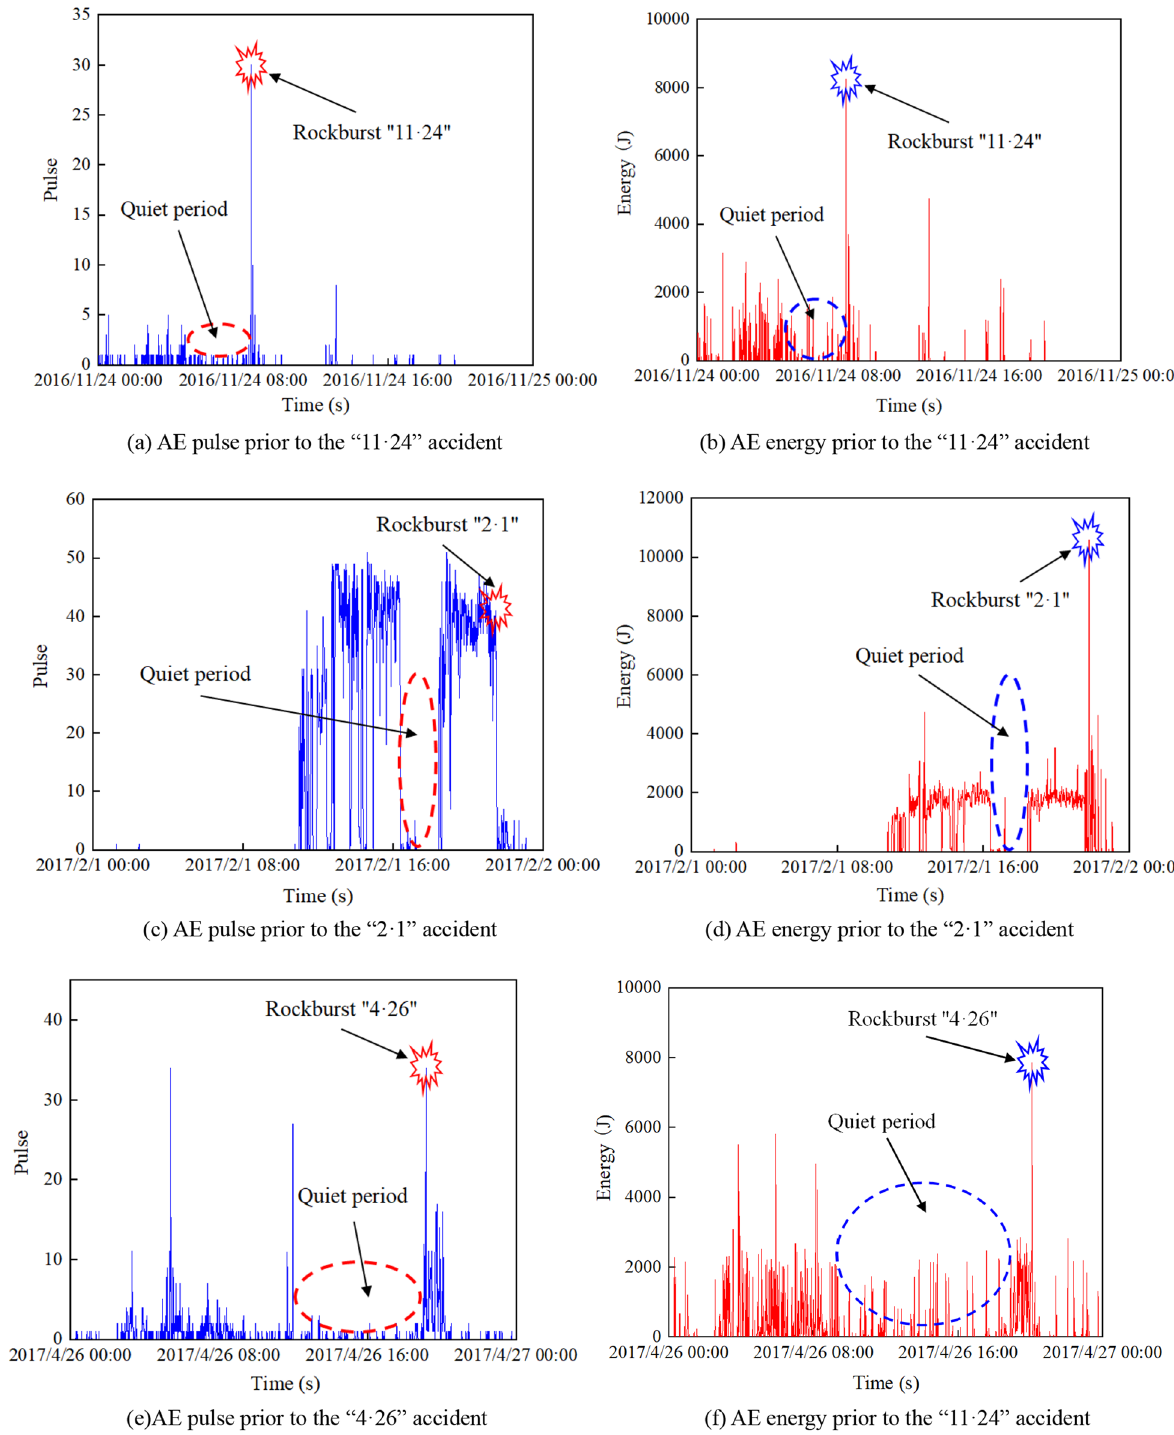
Fig. 8 Temporal variation of AE pulse and energy prior to coal dynamic disaster